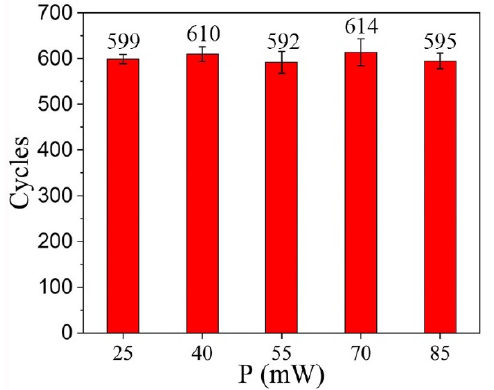
Figure 4. Droplet manipulation repetitions of HD-PTSS with different laser